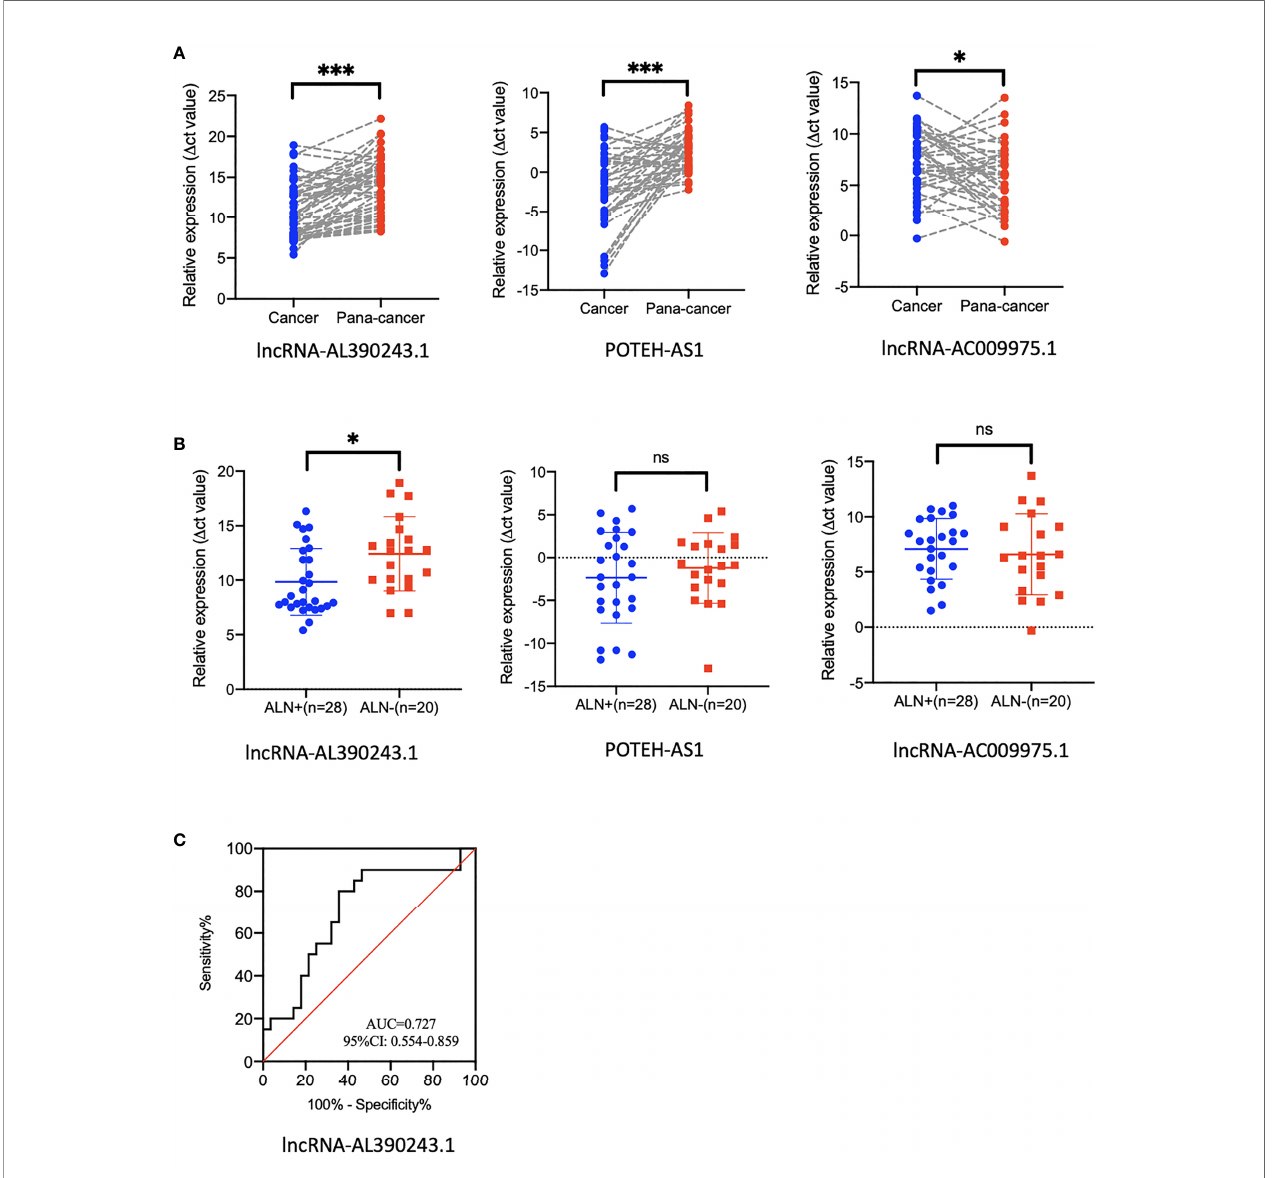
FIGURE 6 | The expression of lncRNA in tissues that did not receive NAT. (A) The expression of lncRNA-AL390243.1, POTEH-AS1, and lncRNA-AC009975.1 in breast cancer tissue and para-cancer tissues. (B) The expression of lncRNA-AL390243.1, POTEH-AS1, and lncRNA-AC009975.1 in nodal positive tissues and nodal negative tissues. (C) The AUC value of lncRNA-AL390243.1 in predicting nodal metastasis was 0.727. *p < 0.05; ***p < 0.0005; ns, no signi fi